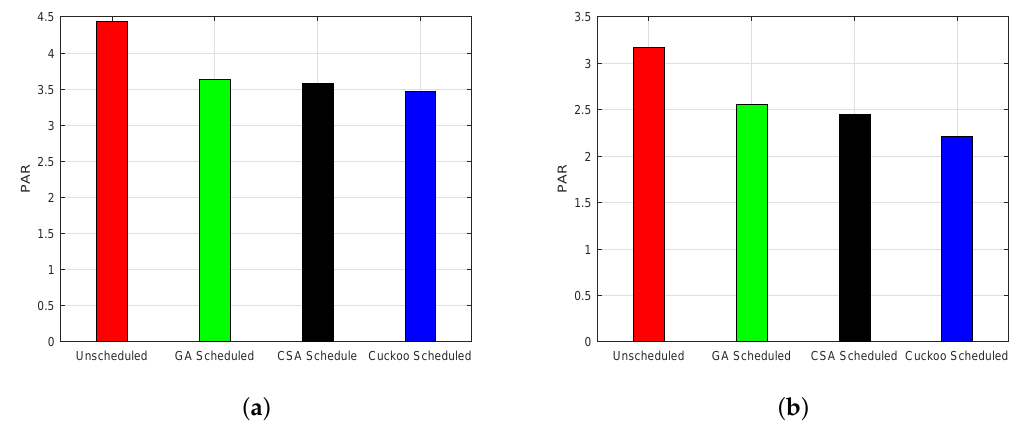
Figure 14. PAR for single and multiple homes with CPP signals. ( a ) PAR for a single smart home; ( b ) PAR for 30 smart